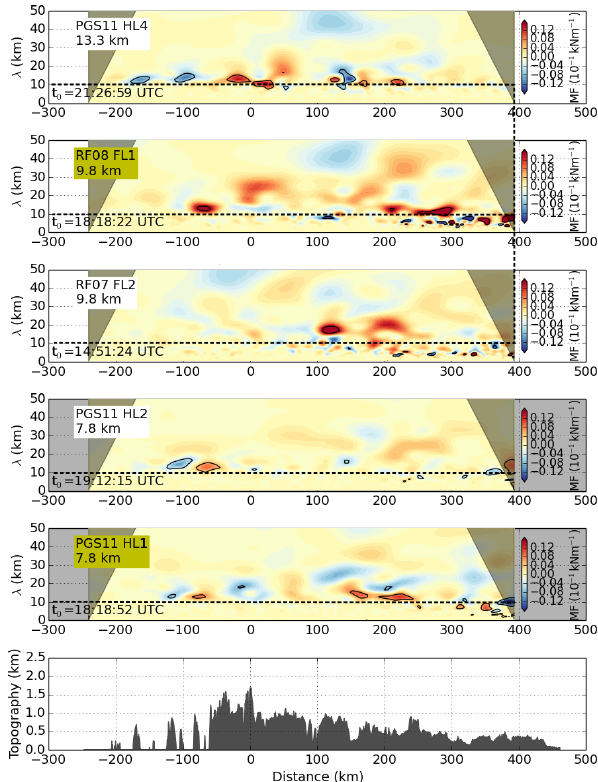
Figure 7. As in Fig. 6b but showing wavelet cospectra of MF ( ρu (cid:48) w (cid:48) ).